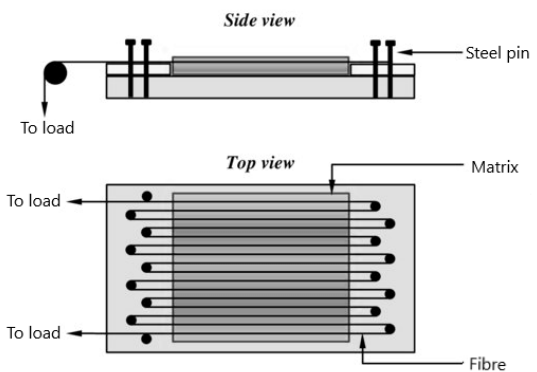
Figure 2. The deadweight prestressing method used by Jorge, Marques and De Castro [6].